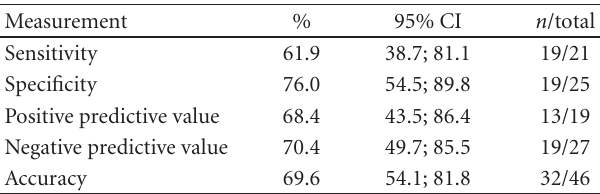
Table 2: Measurements of accuracy for obstruction through the new